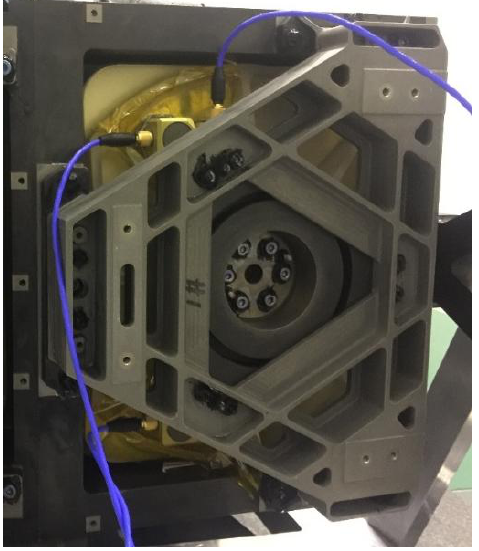
Figure 10. Distribution of acceleration sensors pasted on PM.